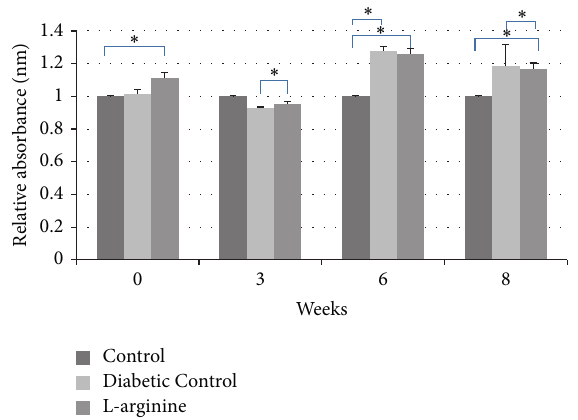
Figure 6: Effect of the high fructose diet alone and high fructose plus L-arginine diet on nitrotyrosine absorbance levels over 8 weeks relativetotheNondiabeticControl.DiabeticControlandL-arginine versus Control: ∗ 𝑃 < 0.05